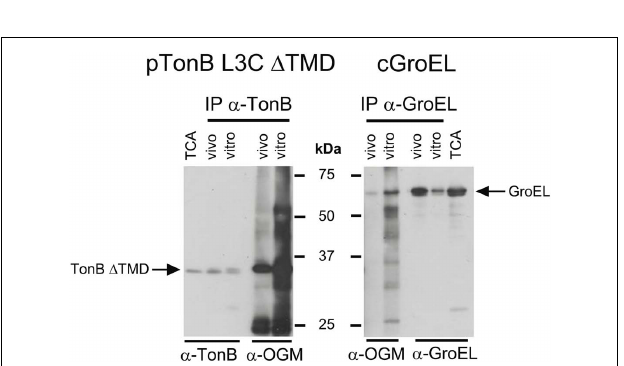
FIGURE 6 | Oregon Green maleimide labels cytoplasmic proteins. OGM labeling and subsequent immunoprecipitation were performed as described in Section “Materials and Methods” with the following strains: cGroEL (W3110 expressing chromosomally encoded GroEL) and pTonB L3C Δ TMD (KP1344/pKP544). Samples of cells were also lysed by passage through a French pressure cell and labeled in vitro ; these served as a standard for 100% labeling . L-Arabinose was added to induce expression of TonB L3C Δ TMD (0.002%). Proteins were also harvested by treatment with TCA to serve as a total protein control. Samples were divided and resolved on 11% SDS-polyacrylamide gels and immunoblotted with anti-TonB or anti-GroEL antibodies for half of the samples and with anti-OGM antibodies for the other half. Positions ofTonB L3C Δ TMD and GroEL are indicated. Molecular mass standards are shown in the center. Abbreviation: IP,